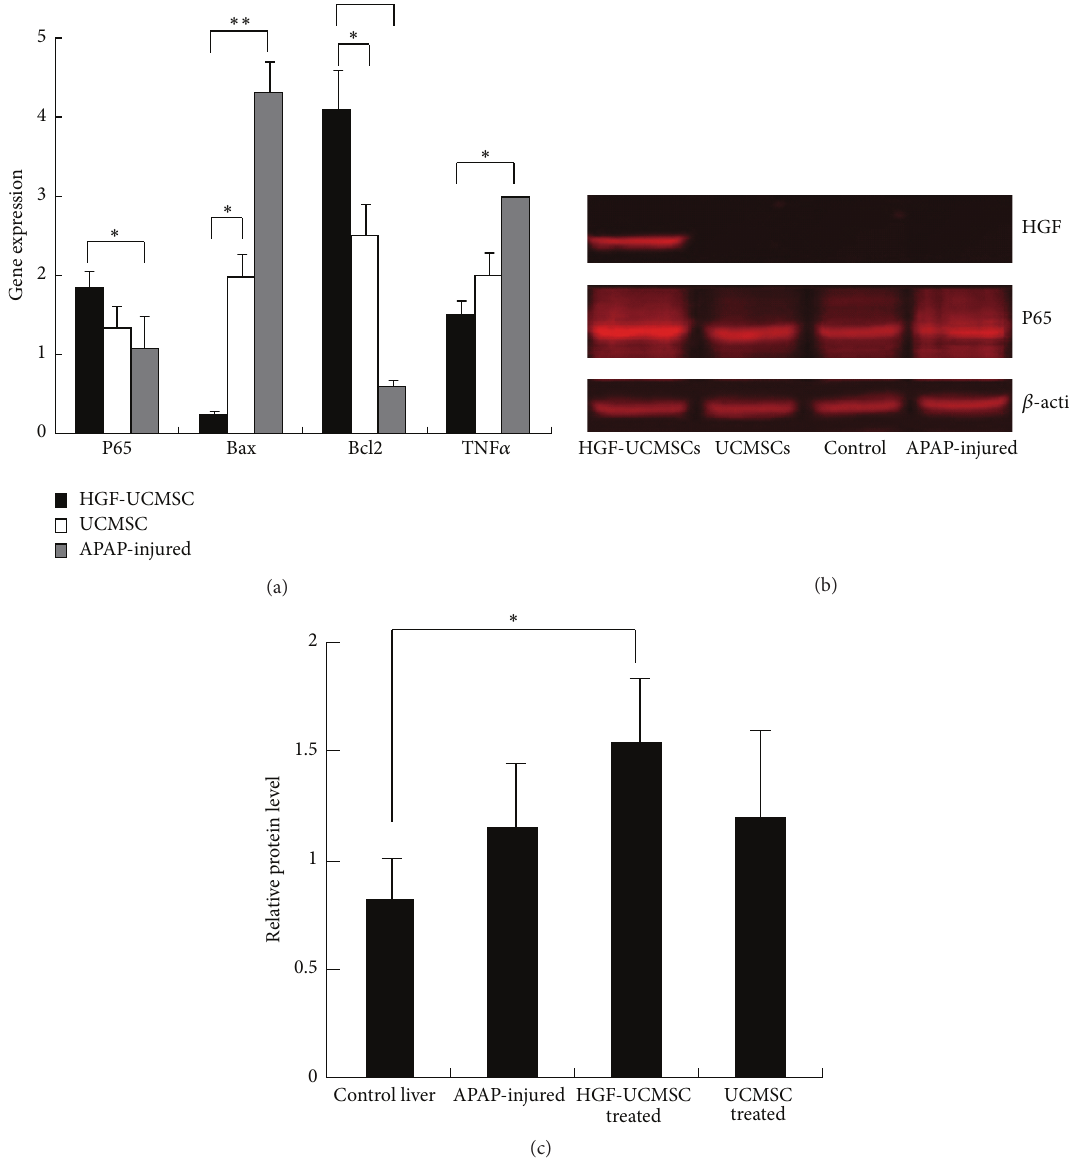
Figure 6: HGF-UCMSCs reduce apoptosis in the liver of ALF mice. (a) Quantitative PCR analysis of mRNA expression of P65, Bcl-2, Bax, and TNF 𝛼 genes in the liver collected from different treatment groups. ∗ 𝑃 < 0.05 ; ∗∗ 𝑃 < 0.01 . (b-c) Western blot of HGF and P65 in the liver of ALF mice. The data are expressed as the means ± SD of three independent experiments. ∗ 𝑃 < 0.5 compared with the